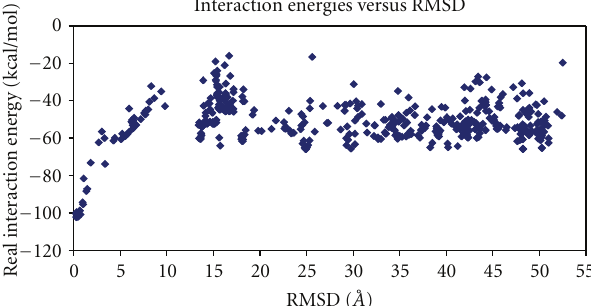
Figure 5: Interaction energies versus RMSD of the 500 representa- tive conformations of 1CHO from real potential optimization. The RMSD calculations are based on the C α atoms of the crystal and optimized structures.